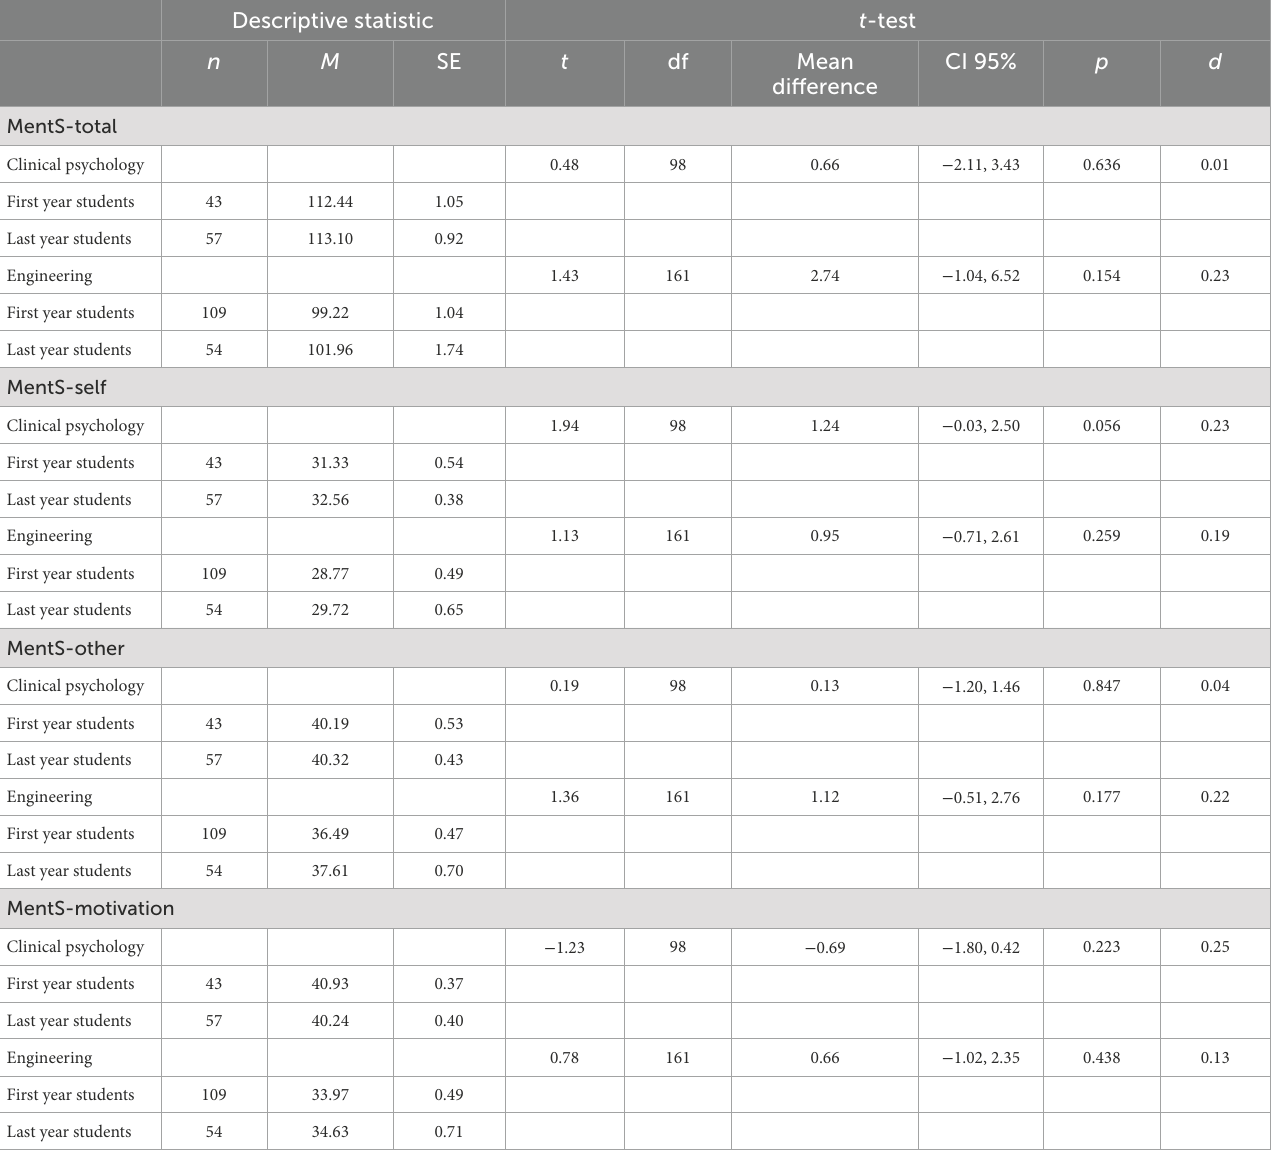
TABLE 3 T -test for comparisons of first and last year